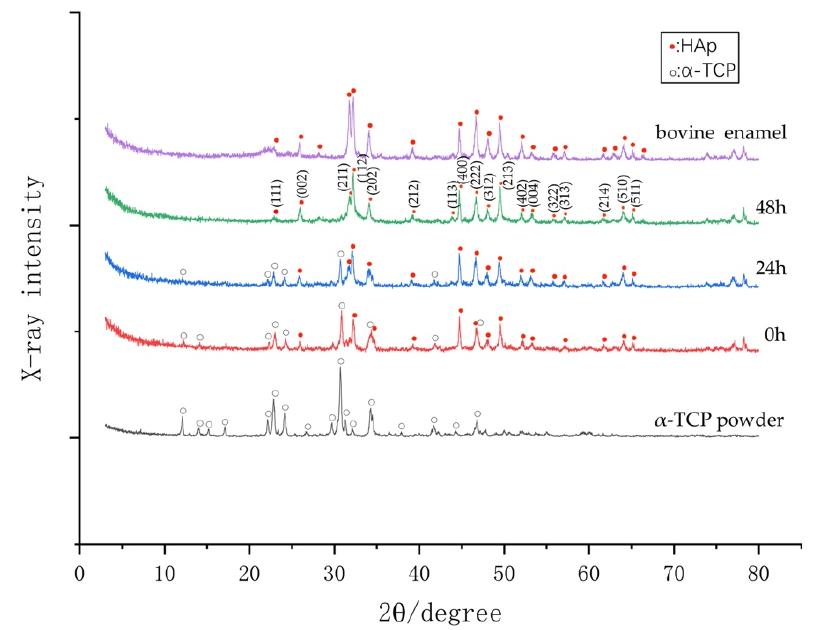
Figure 8. X-ray diffraction patterns of the α -TCP powder, deposited film coating immediately after Figure 8. X ‐ ray diffraction patterns of the α‐ TCP powder, deposited film coating immediately after PLD, coatings after hydrolyzation for 24 h and 48 h, and bovine dental enamel. PLD, coatings after hydrolyzation for 24 h and 48 h, and bovine dental